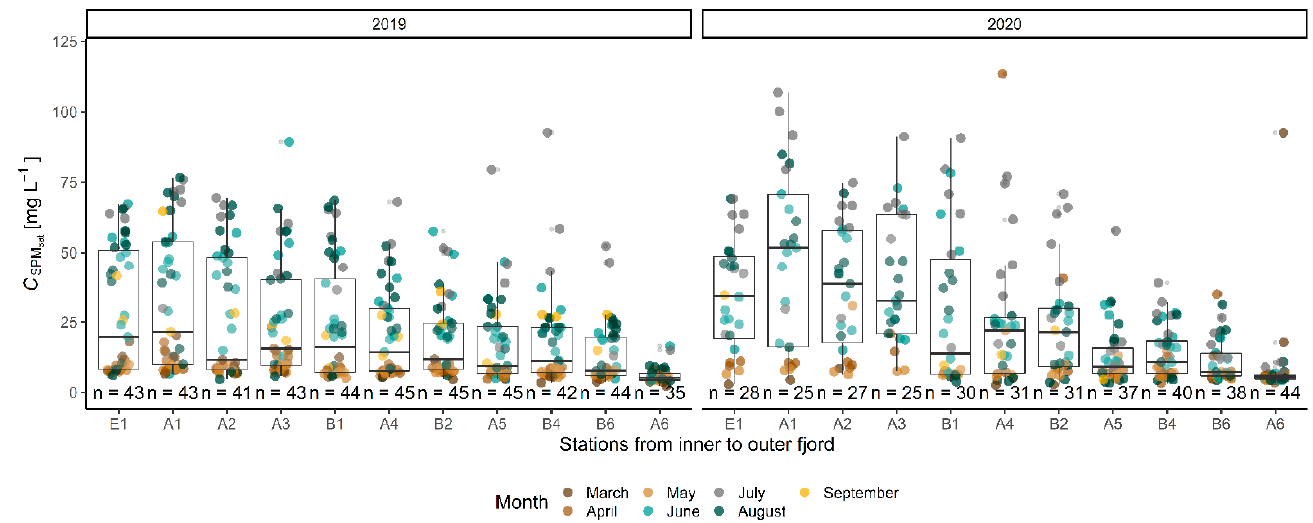
at the sampling at the sampling sat (cid:3177)(cid:3159)(cid:3178)